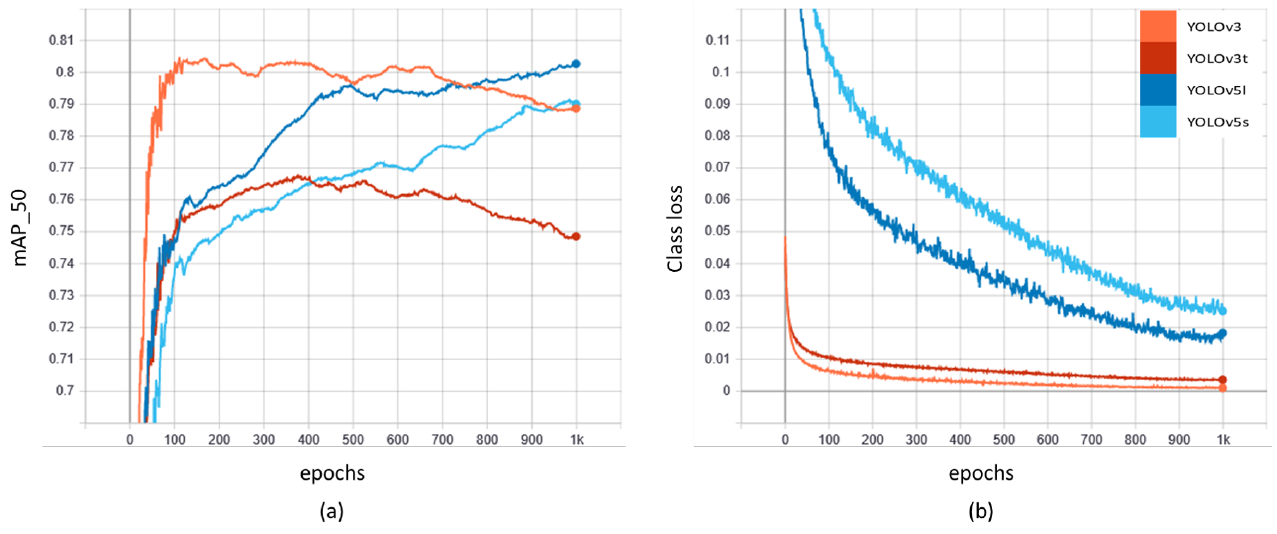
Figure 5. Network training results of YOLOv3, YOLOv3t, YOLOv5l, and YOLOv5s on the TR1 dataset. ( a ) mAP at IoU = 50; ( b ) classification loss.